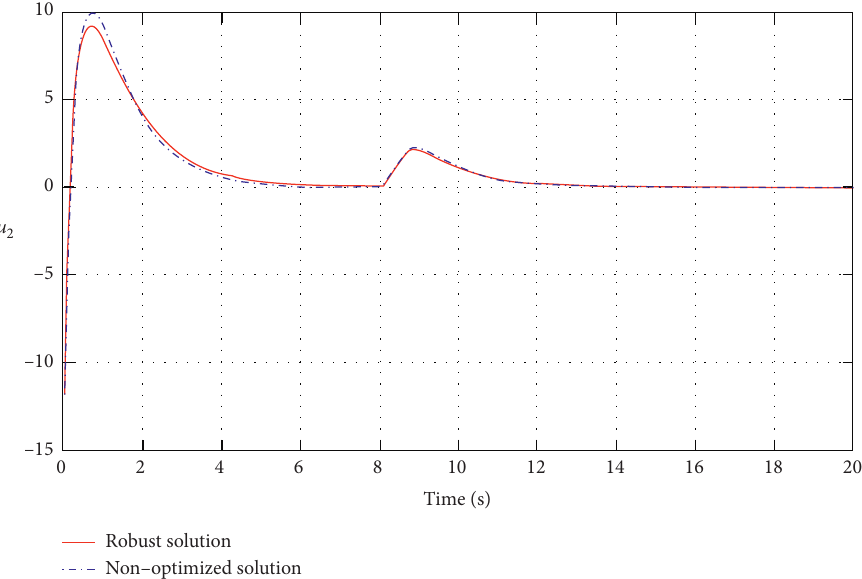
Figure 6: Comparison of u